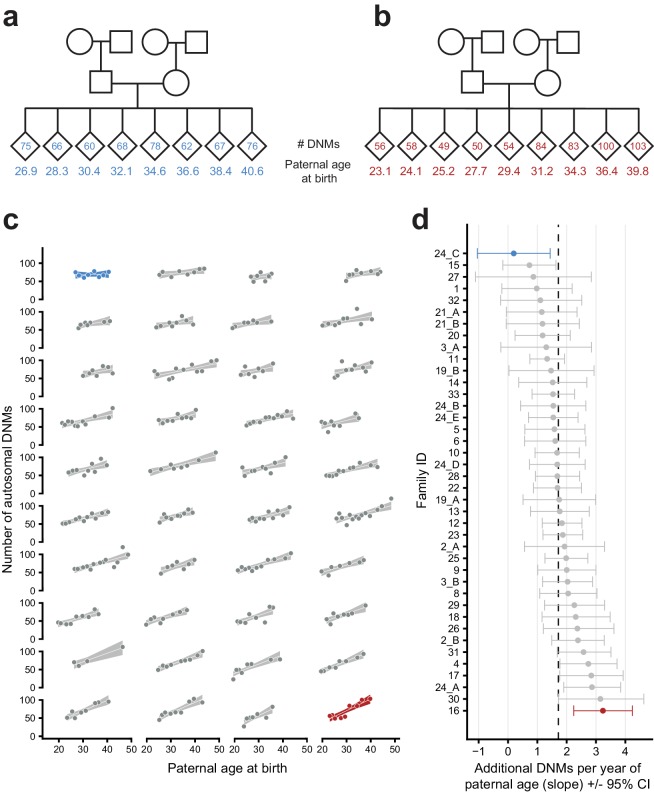
Parental age effects on autosomal germline mutation counts vary significantly among CEPH/Utah families.Illustrations of pedigrees exhibiting the smallest (family 24_C, panel a) and largest (family 16, panel b) paternal age effects on third-generation DNM counts demonstrate the extremes of inter-family variability. Diamonds are used to anonymize the sex of each third-generation individual. The method used to separate CEPH/Utah pedigrees into unique groups of second-generation parents and third-generation children is presented in Figure 3—figure supplement 1. Third-generation individuals are arranged by birth order from left to right. The number of autosomal DNMs observed in each third-generation individual is shown within the diamonds, and the age of the father at the third-generation individual’s birth is shown below the diamond. The coloring for these two families is used to identify them in panels c and d. (c) The total number of autosomal DNMs is plotted versus paternal age at birth for third-generation individuals from all CEPH/Utah families. Regression lines and 95% confidence bands indicate the predicted number of DNMs as a function of paternal age using a Poisson regression (identity link). Families are sorted in order of increasing slope, and families with the least and greatest paternal age effects are highlighted in blue and red, respectively. (d) A Poisson regression (predicting autosomal DNMs as a function of paternal age) was fit to each family separately; the slope of each family’s regression is plotted, as well as the 95% confidence interval of the regression coefficient estimate. The same two families are highlighted as in (a). A dashed black line indicates the overall paternal age effect (estimated using all third-generation samples). Families are ordered from top to bottom in order of increasing slope, as in (c). A random sampling approach was used to assess the robustness of the per-family regressions to possible outliers; the results of these simulations are shown in Figure 3—figure supplement 2.